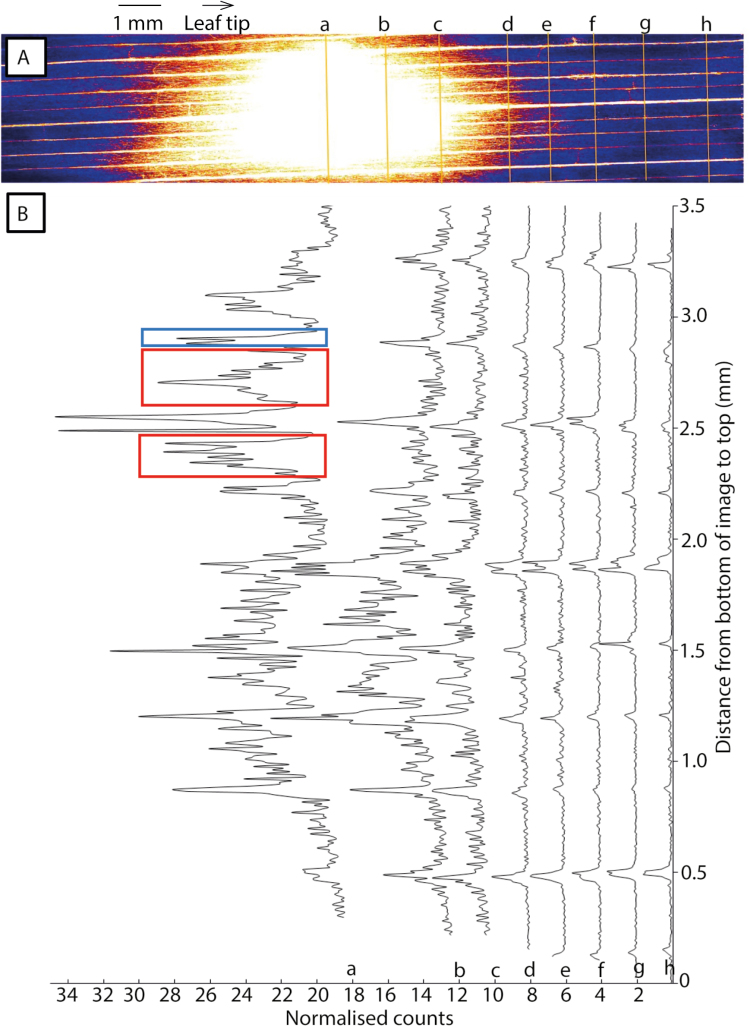
XFM image (A) of a leaf treated with a droplet of ZnSO4 and removed after 6 h (XFM Experiment 2). Line scans (B) were collected across the leaf at locations shown by the yellow lines in the XFM image (transects a–h). The red dashed rectangles indicate intervein areas with a high Zn concentration. The intensity of these peaks significantly decreases moving away from the hot spots (i.e. transect b), whereas similar Zn concentrations in the veins (blue square) do not decrease to the same extent in transect b.